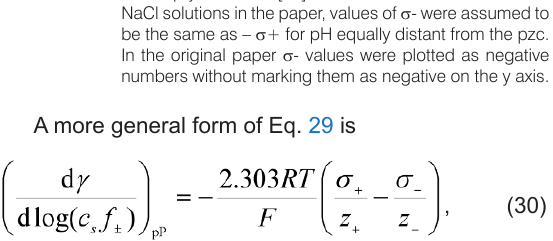
Figure 2. Influence of KNO3 activity on ionic components of charge for AgI at selected pAg values (data taken from Lyklema